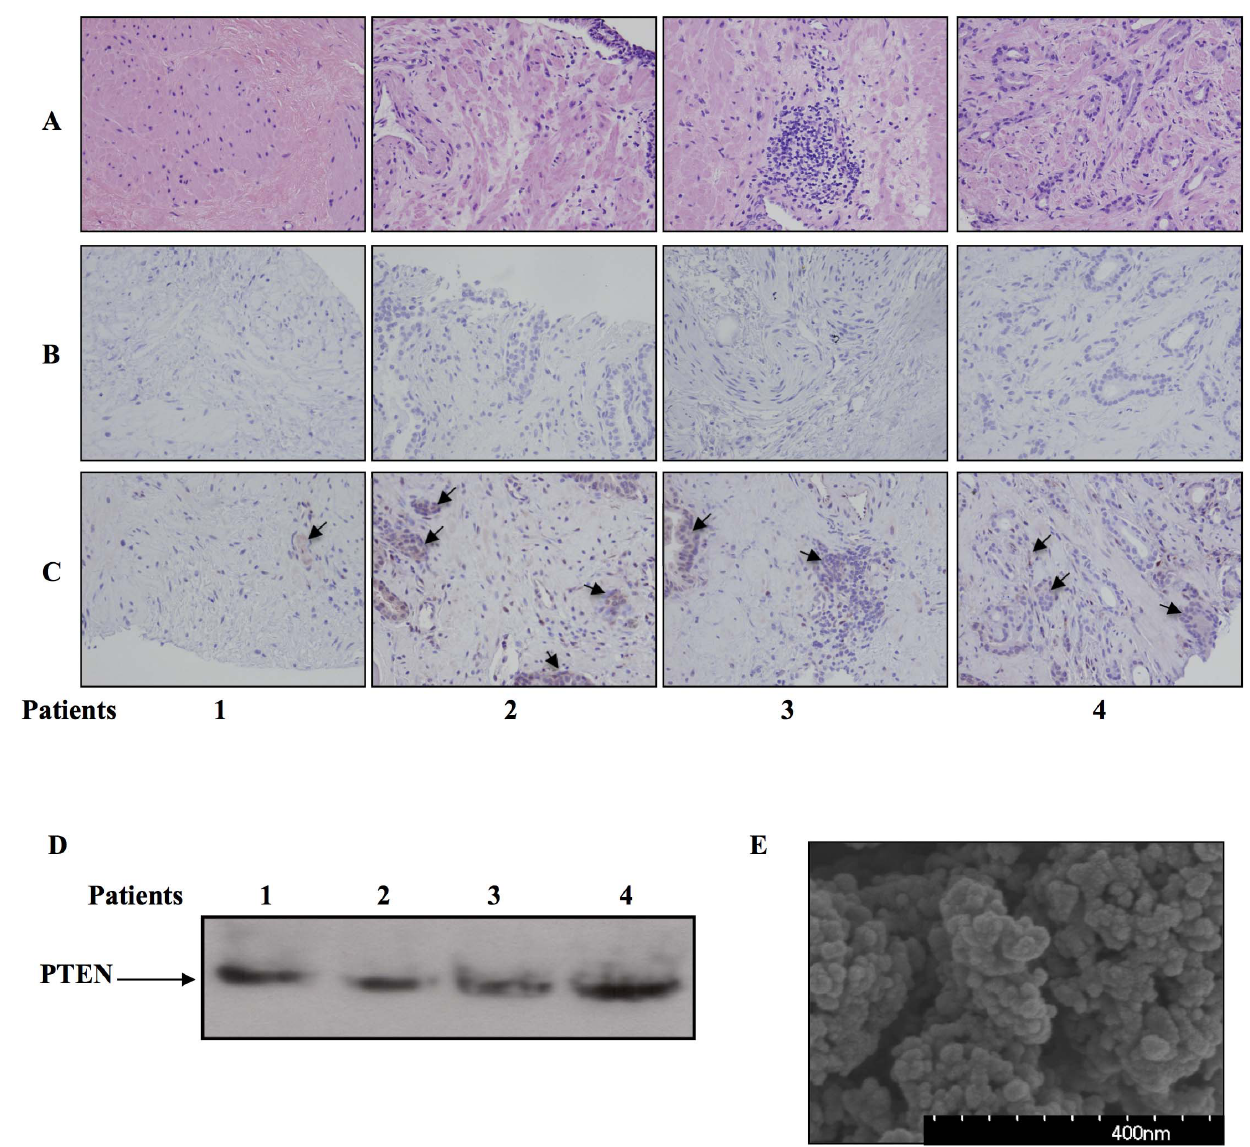
Figure 7. Exosomes provide a noninvasive, quantitative method to assess PTEN status in PC patients. This figure provides a comparison study of PTEN assessment using exosomal PTEN, and Immunohistochemistry of PC patient tumors. Immunohistochemistry of tumor tissues from four PC patients demonstrates the heterogeneity of PTEN expression in prostate tumors. A. Eosin & hematoxylin staining. B. Staining with secondary antibodies. C. Staining with PTEN specific antibodies, arrows indicate PTEN positive cells. D. Assessment of PTEN expression using plasma exosomes from the same patients. E) A scanning electron microscope micrograph showing the homogenous population of exosomes collected from the patient blood. Exosomes were attached to a cover slip using polylysine, and processed for scanning electron